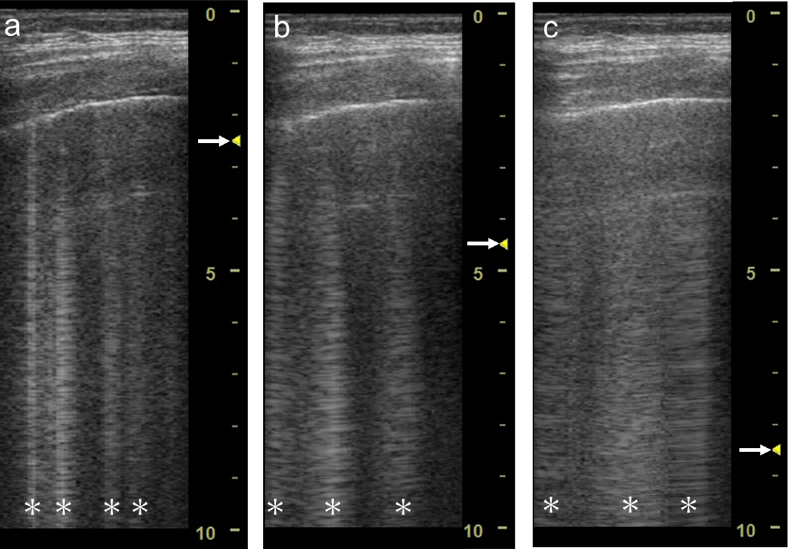
Figure 7. Ultrasound images obtained by Venue scanner (GE Healthcare) with a curvilinear trans- ducer. The B-line becomes wider as the single focal point (arrow) is shifted from the same level as the pleural line ( a ) to a deeper level ( b ).